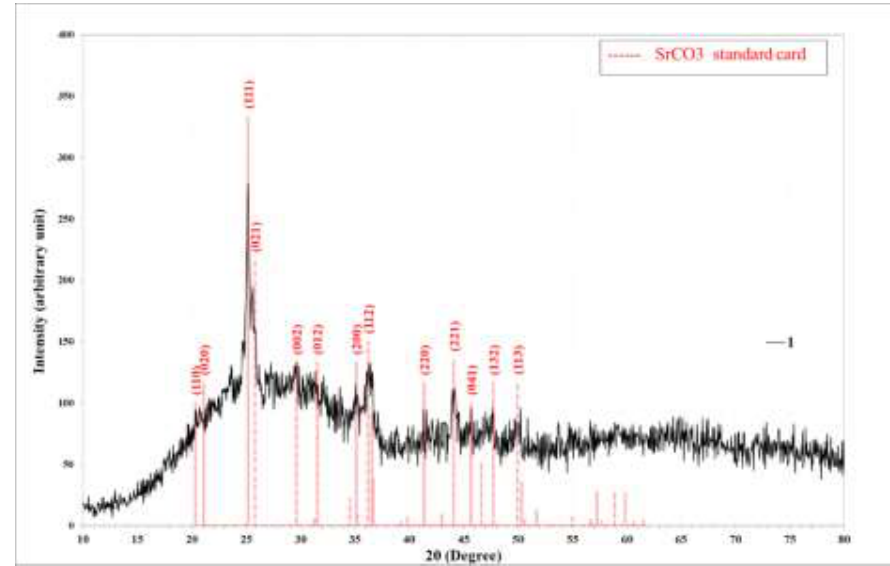
Fig.4: X-ray diffraction CNTs-Sr(OH)